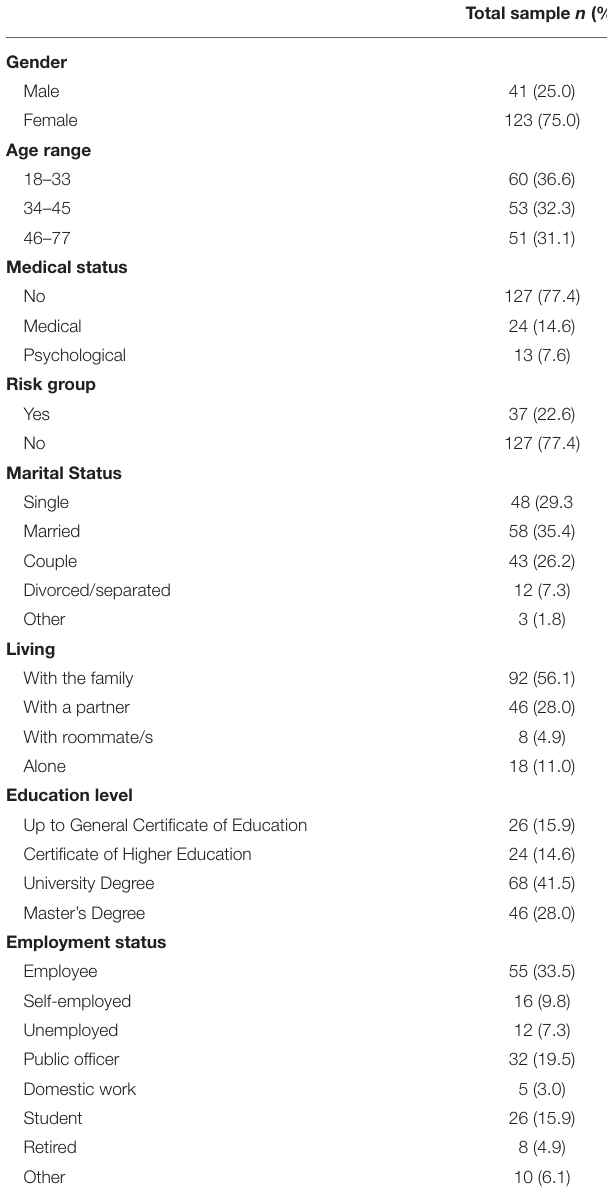
TABLE 1 | Sociodemographic characteristics of the total sample ( N =